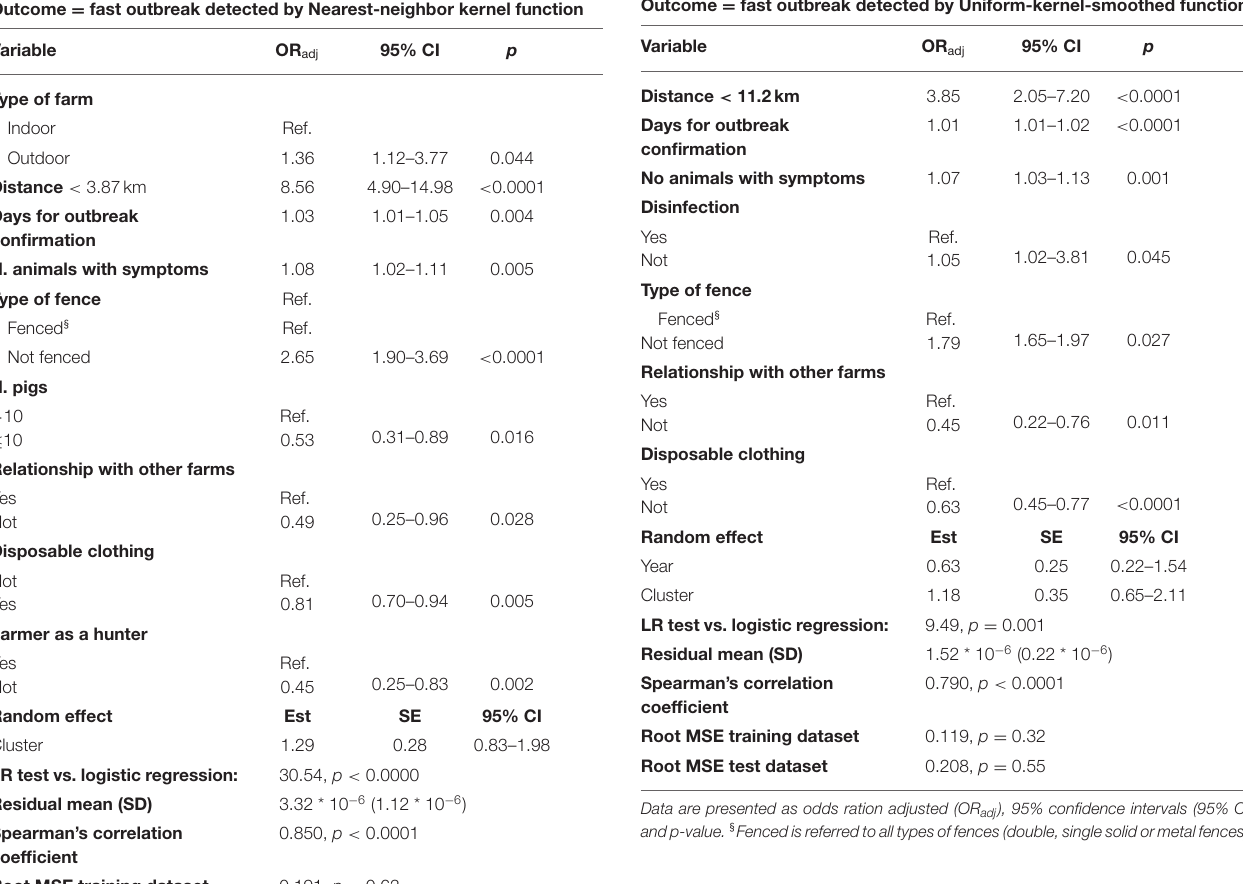
TABLE 4 | Logistic mixed model results using fast ( y = 1) or normal ( y = 0) outbreaks as outcome, with a cut-off < 16 or ≥ 16 days from primary case for categories definition, based on Nearest-neighbor kernel function.